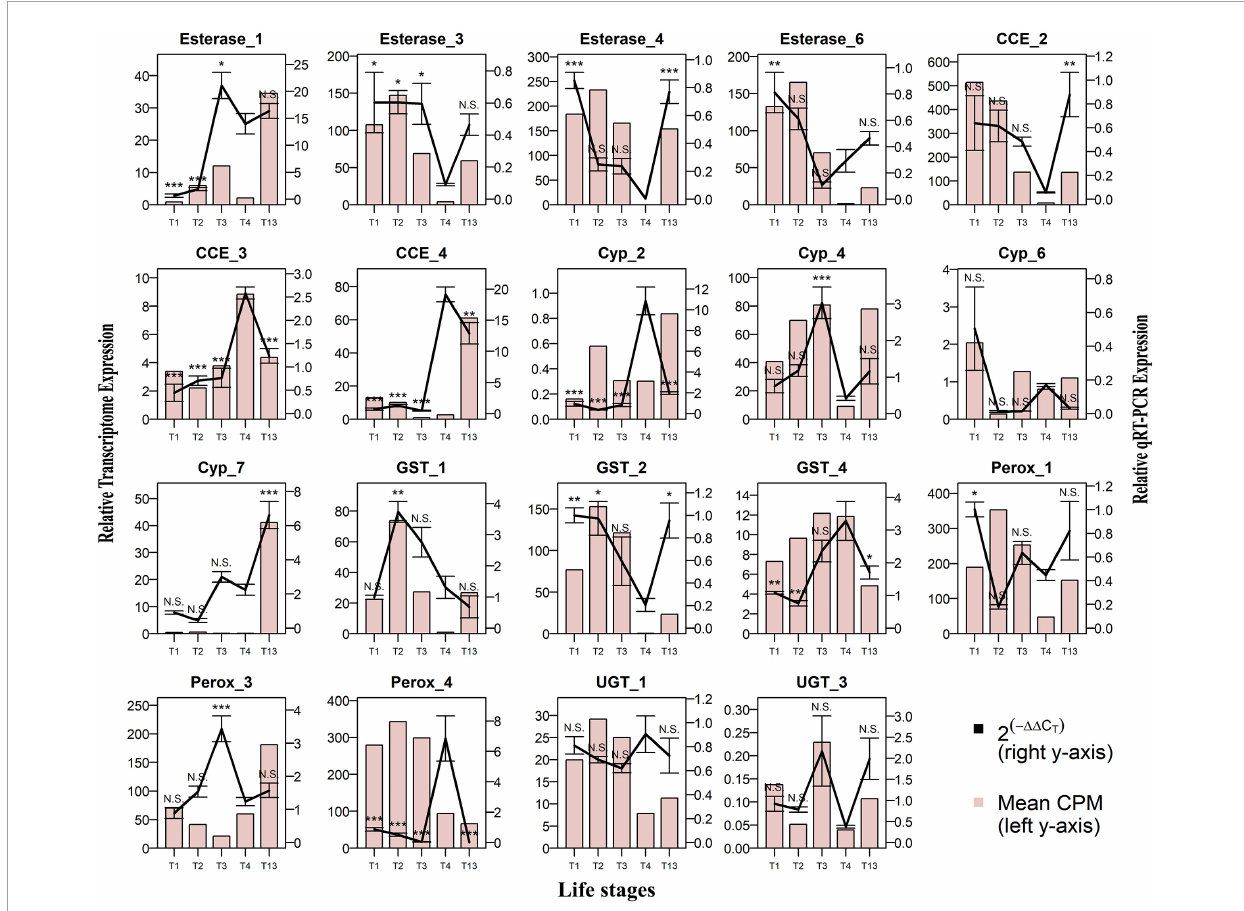
FIGURE11 Comparison of RNA-seq and RT-qPCR data for the relative expression of 19 genes in developmental life stages. Life stages: 1st instar larvae (T1), 2nd instar larvae (T2), 3rd instar larvae (T3), pupae (T4), and sclerotized adult beetles (T13) on the x -axis plotted against relative expression in RNA seq ( N = 5) represented as mean CPM on the left y -axis, and relative expression in RT-qPCR ( N = 4) represented as mean 2ˆ-( (cid:49)(cid:49) Ct) ± S.E. on the right y-axis. The bar graph represents CPM-based expression from RNA-seq, and the solid line represents RT-qPCR expression. Tukey’s HSD was performed with a 95% confidence level with T4 as the control group, and p -values were generated as per the fit model. * represents p < 0.05, ** represents p < 0.01, *** represents p < 0.001, and N .S. represents non-significant